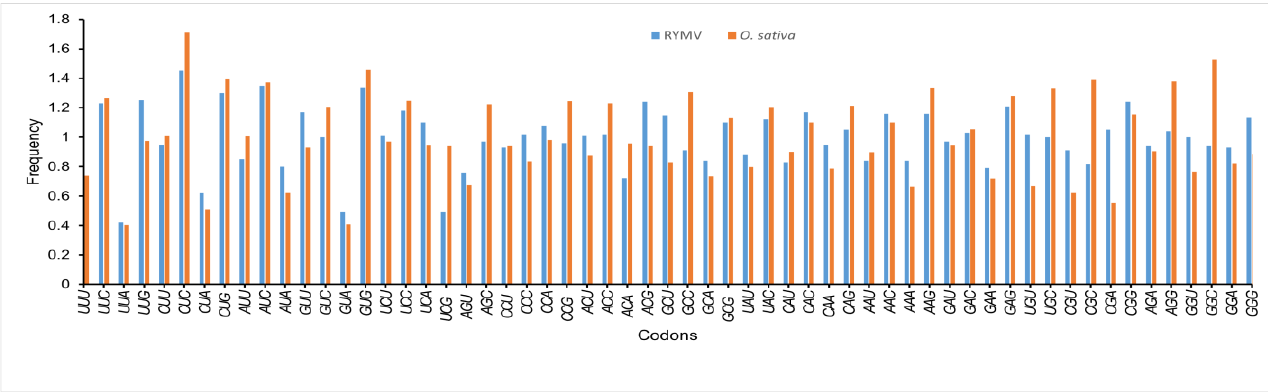
Figure 2. A comparative analysis of RSCU patterns between Rice yellow mottle virus (RYMV), and its host O. Sativa . X -axis represents Codons. Y -axis represents Frequency. Table 2. The relative synonymous codon usage frequency of RYMV and its natural host.